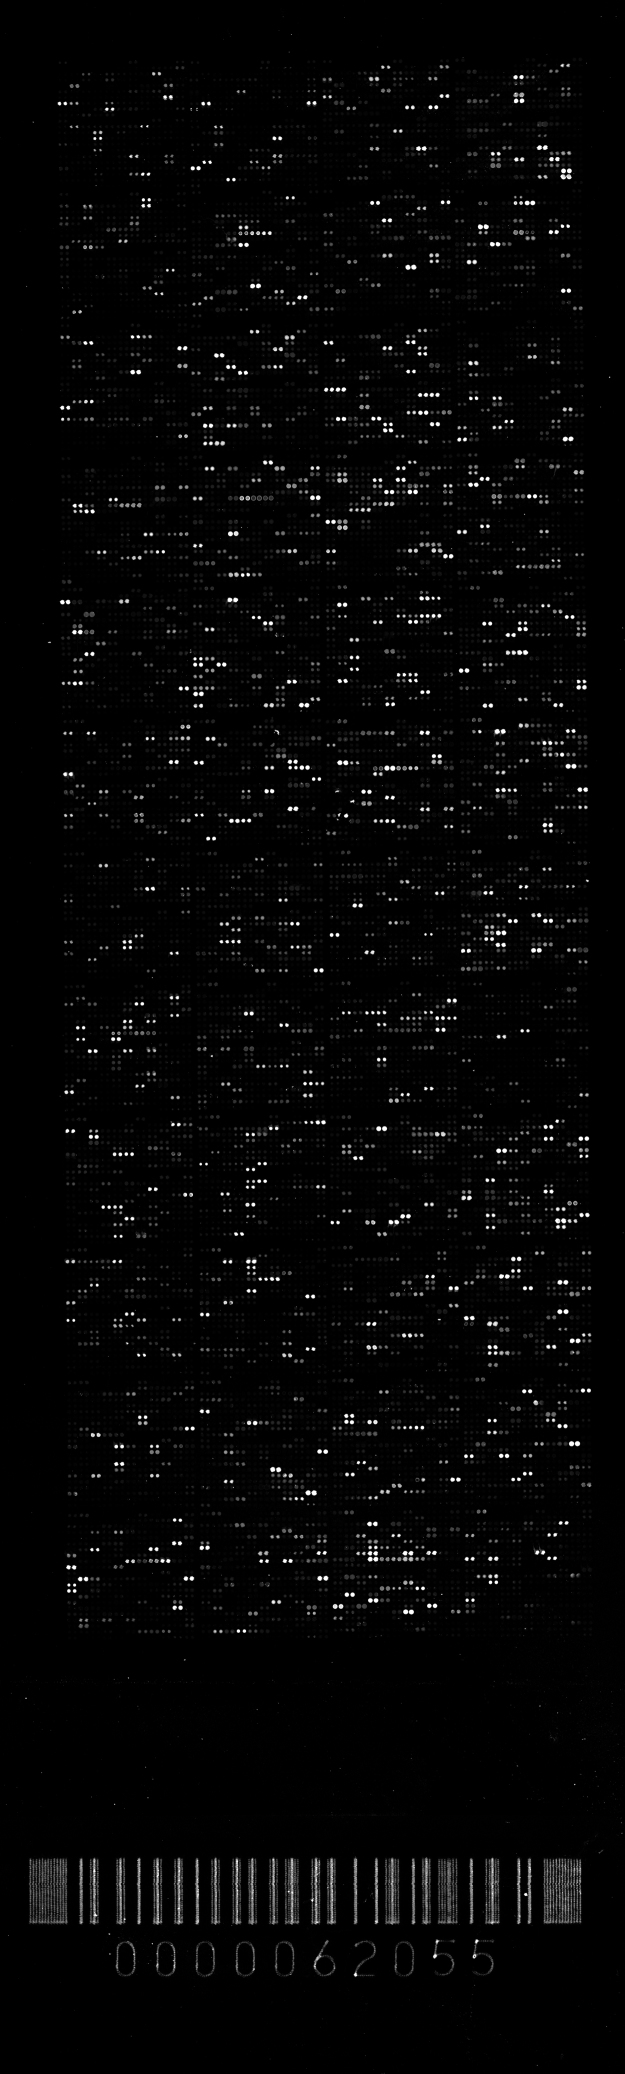
High Resolution Array Image. Experimental assay with G4-2, profiled at 25 μM.